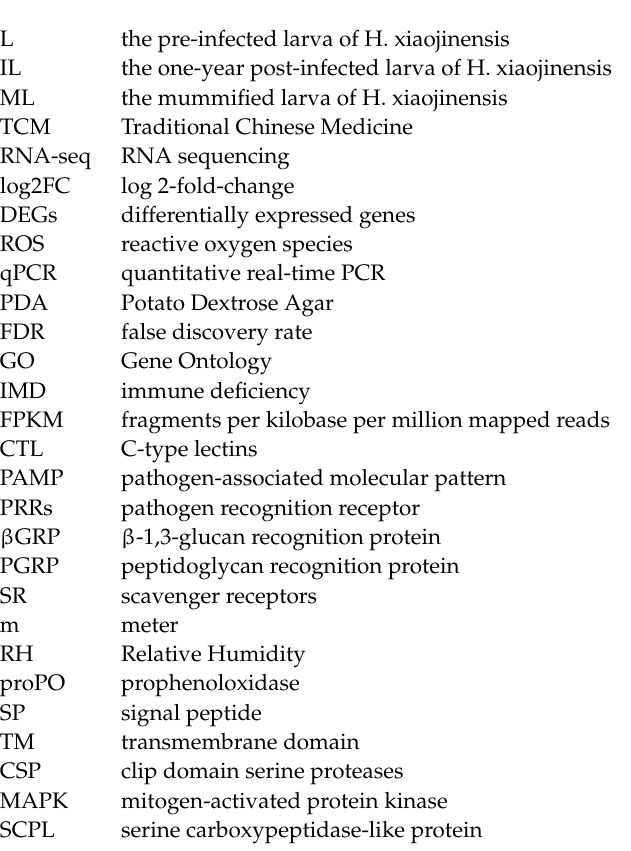
Table S3: Differentially expressed genes in IL vs. L; Table S4: GO classification of DEGs in IL vs. L; Table S5: The KEGG annotations of DEGs in IL vs. L.; Table S6: The list of immune-related genes in H. xiaojinensis ; Table S7: The differentially expressed genes in IL vs. ML; Table S8: GO classification of DEGs in IL vs. ML; Table S9: The KEGG annotations of DEGs in IL vs. ML; Table S10: The list of fungal pathogenicity-related genes in O. sinensis ; Table S11: Primers for qPCR. Author Contributions: X.T. designed and performed the experiments, analyzed the data, prepared figures and/or tables, authored or reviewed drafts of the paper, and approved the final draft. J.G. participated in designing the study, provided the samples, and reviewed drafts of the paper. Page: 23 T.P. carried out some of the experiment. S.L. and D.Z. analyzed data. All authors have read and agreed to the published version of the